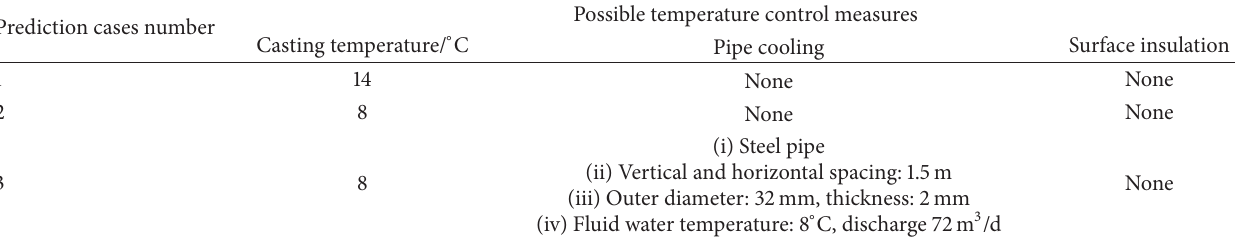
Table 4: Temperature and thermal stress prediction cases at normal